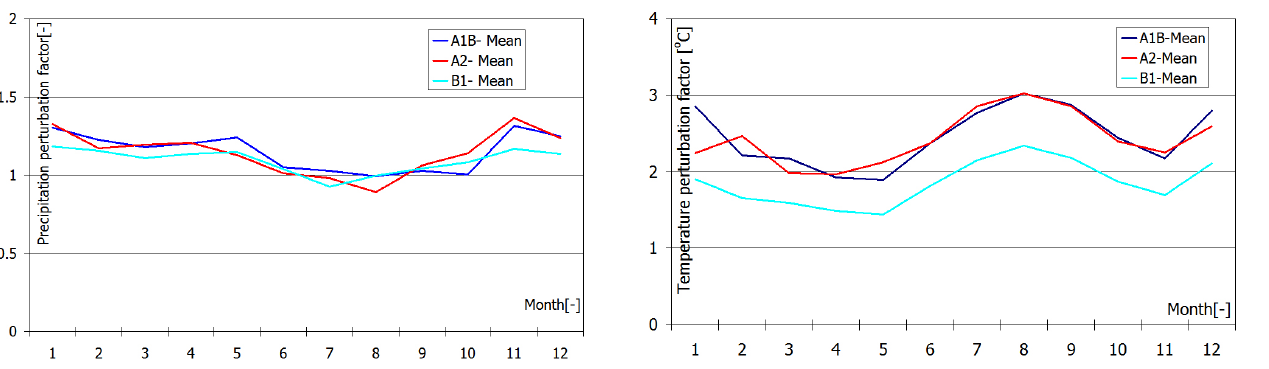
Fig. 10. Mean level of perturbation factor of monthly temperature for A1B, A2 and B1 emission scenarios at BYBLK meteorological station.